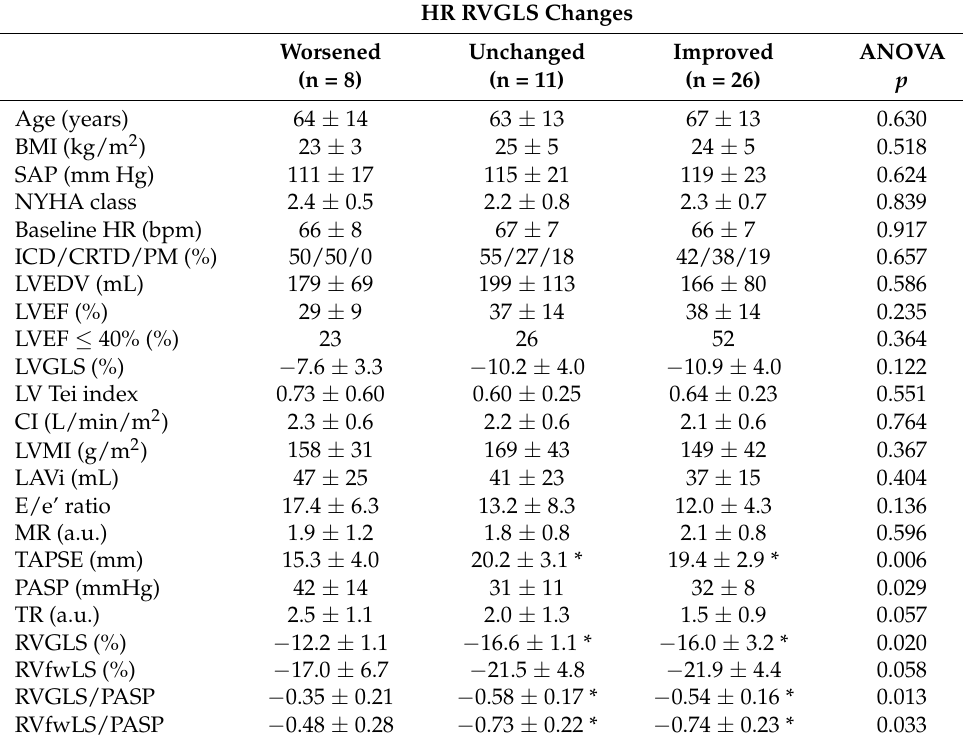
Table 3. HR-dependent changes in RVGLS.